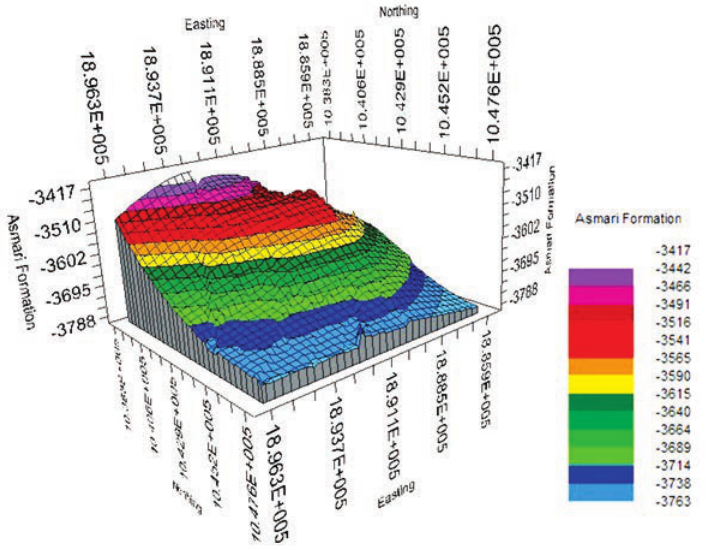
Fig. 7. Final model of the top of Asmari Formation (left view)